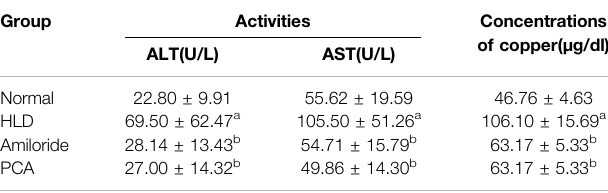
TABLE 2 | Activities of ALT and ALT, and concentrations of copper in sera of